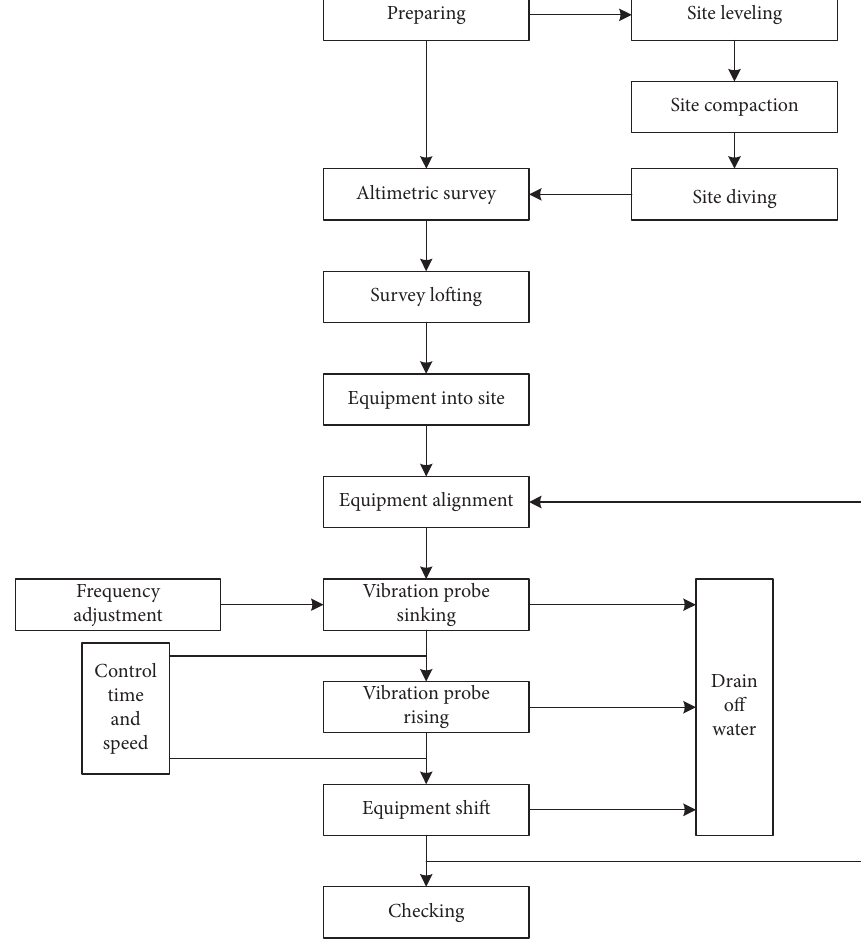
Figure 6: CSPRCM flow